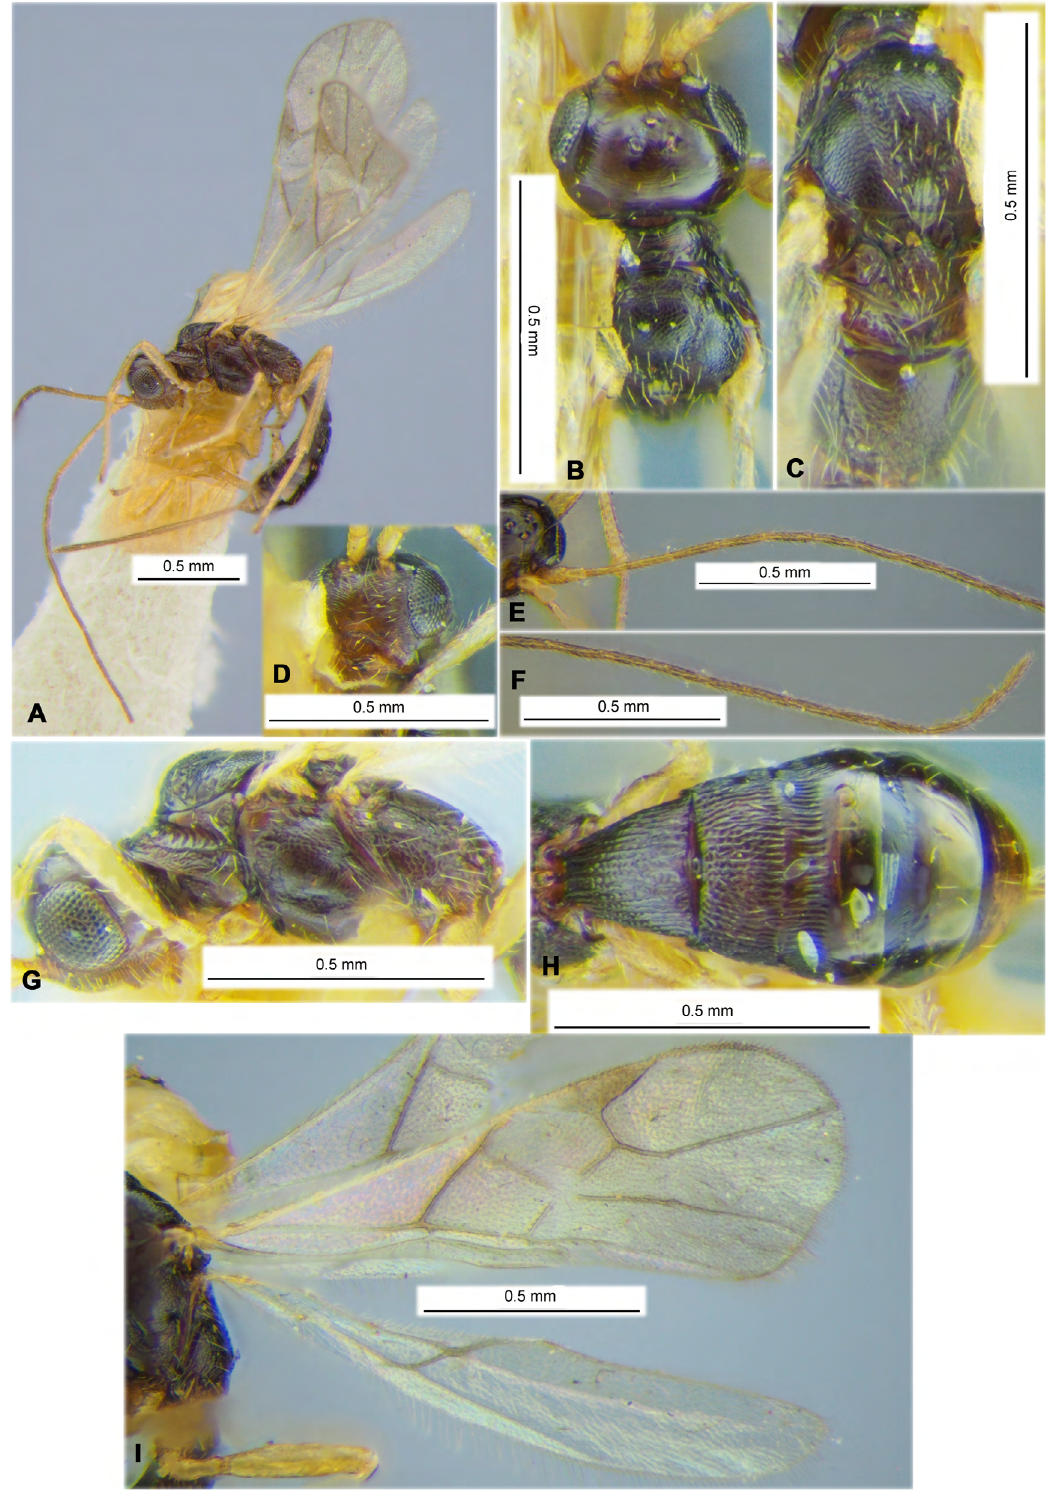
Fig. 51. Rhacontsira haeselbarthi sp. nov., ♀, holotype, SSMG. A . Habitus, lateral view. B . Head and mesoscutum, front view. C . Mesosoma, dorsal view. D . Head, front view. E . Basal segments of antenna. F . Apical segments of antenna. G . Head and mesosoma, lateral view. H . Metasoma, dorsal view. I .